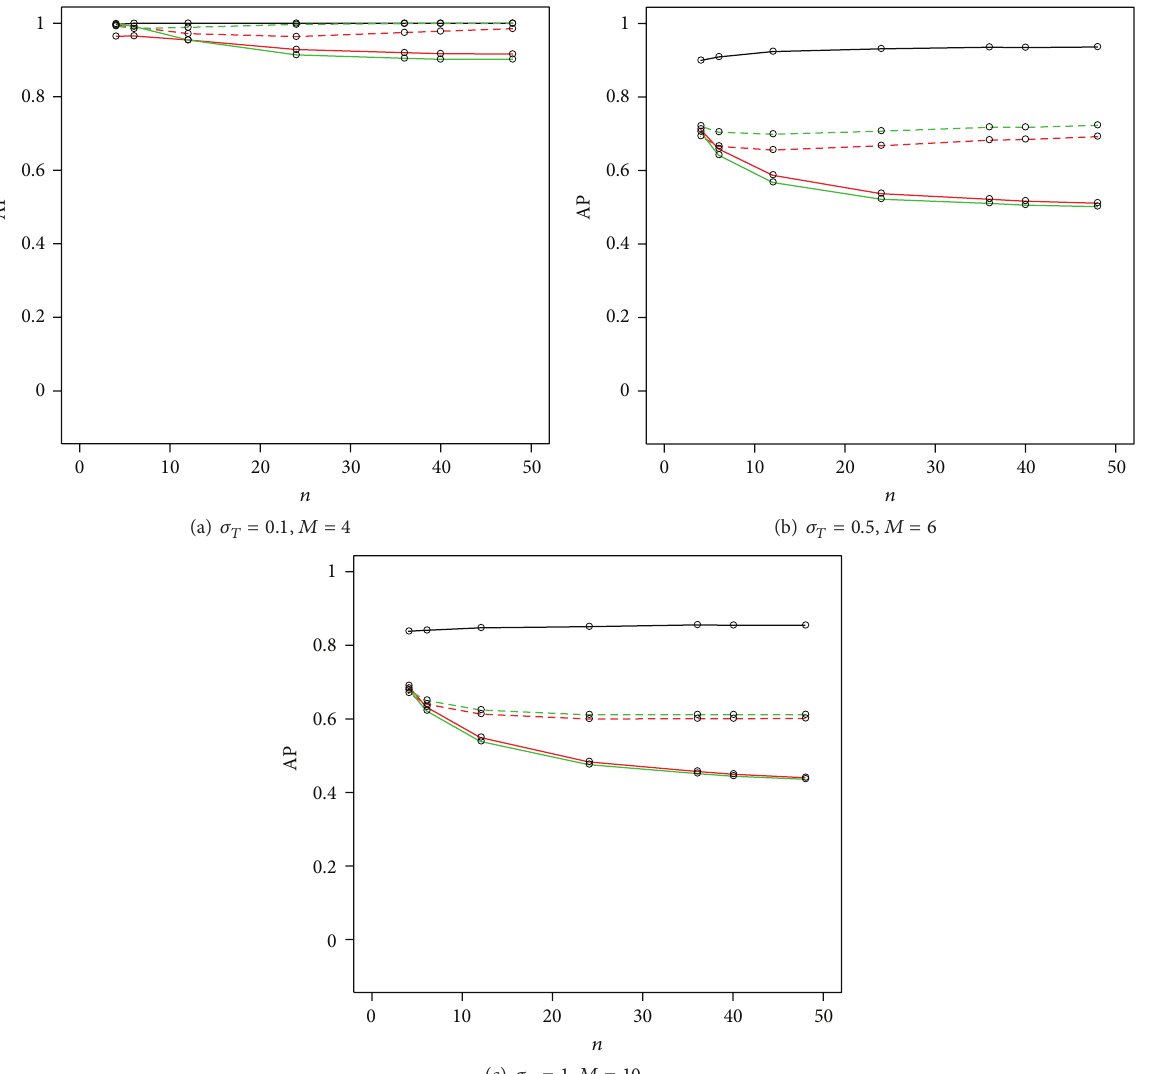
Figure 9: AP for protracted threat using SITMUF joint cusum for 𝑛 = 4, 6,12, 24, 36, 40, 48 (colors black Σ 1 , solid red Σ 2 , dashed red Σ 3 , solid green Σ 4 , dashed green Σ 5 ). Loss of two years is 𝑀